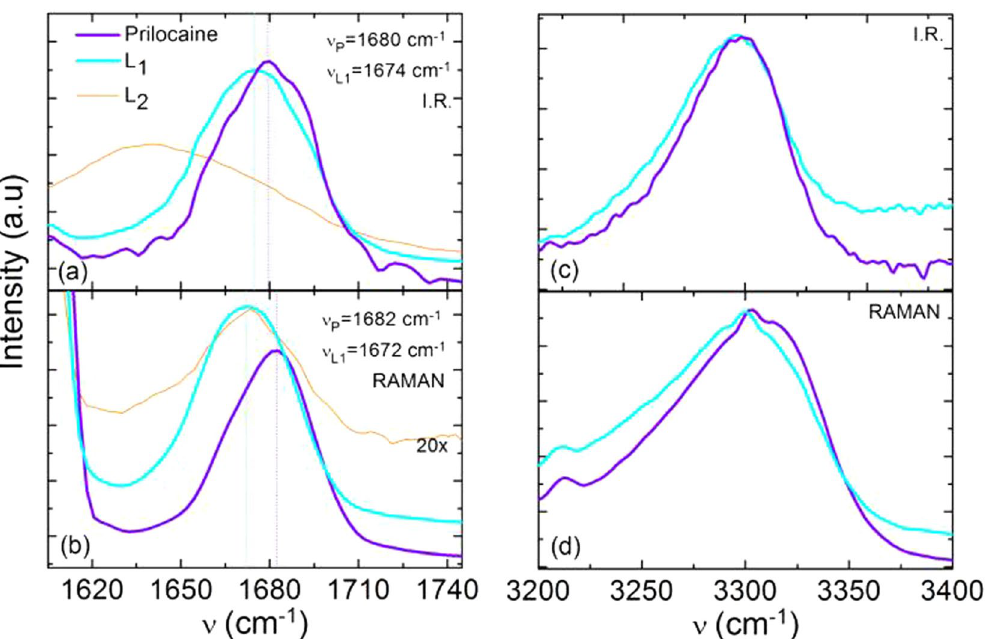
Figure 4. Vibrational spectra of pure and hydrated prilocaine. Attenuated total reflection infrared spectra measured at room temperature in the liquid phase ( a ) and Raman spectra acquired at 220 K on the glass ( b ), between 1605 and 1745 cm − 1 (left panels) and between 3200 and 3400 cm − 1 (right panels). Besides the spectra of pure and hydrated prilocaine, the spectra of a diluted prilocaine solution in water (liquid L 2 ) are also shown for